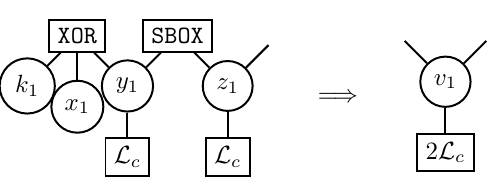
Figure 6: Illustration of the merging